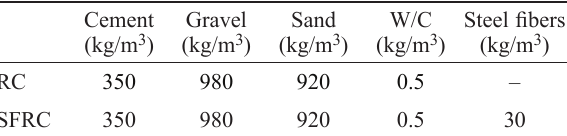
Table 1. Consistence of concrete